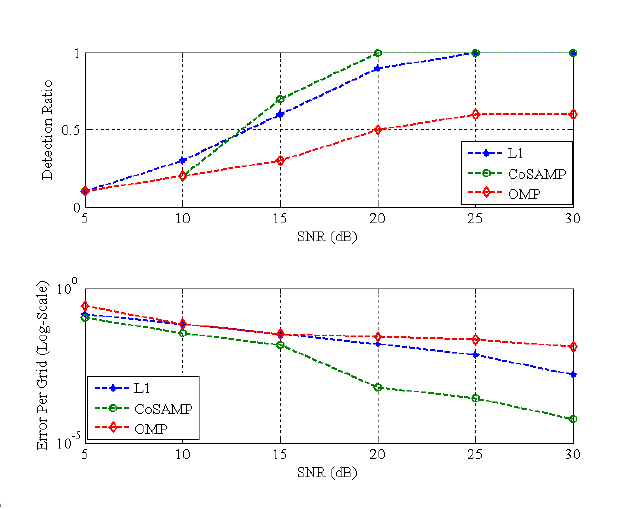
Figure 2. (a) Detection ratio for normal distribution (b) detection ratio for uniform distribution